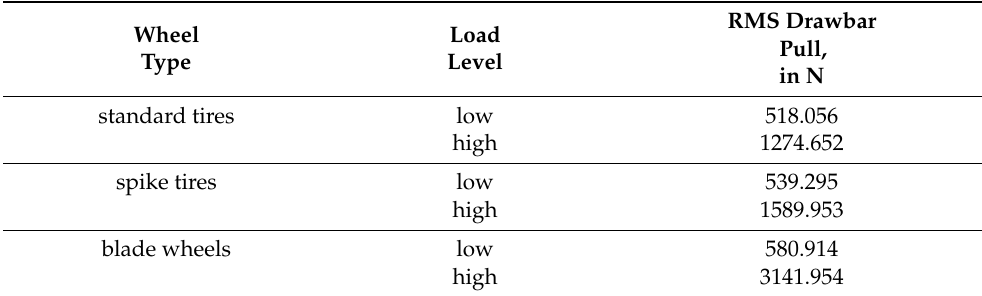
Table 2. Drawbar RMS values of the tractor with different driving wheels with low and high